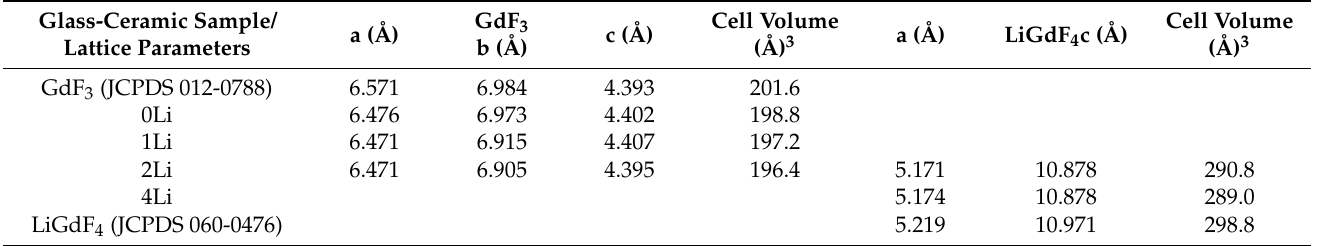
Table 1. The results of the X-ray diffraction (XRD) pattern analysis of Yb 3+ /Er 3+ -doped SiO 2 - GdF 3 -LiGdF 4 nano-glass ceramic; the lattice parameters for GdF 3 (JCPDS-file 012-0788) and LiGdF 4 (JCPDS-file 060-0476) [13] are included for